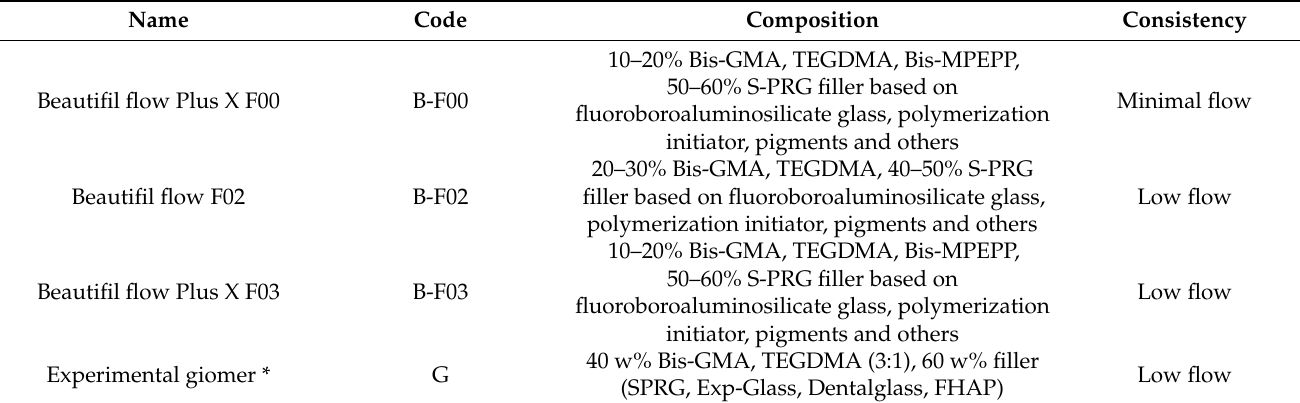
Table 1. Commercial Giomer and experimental flowable giomer